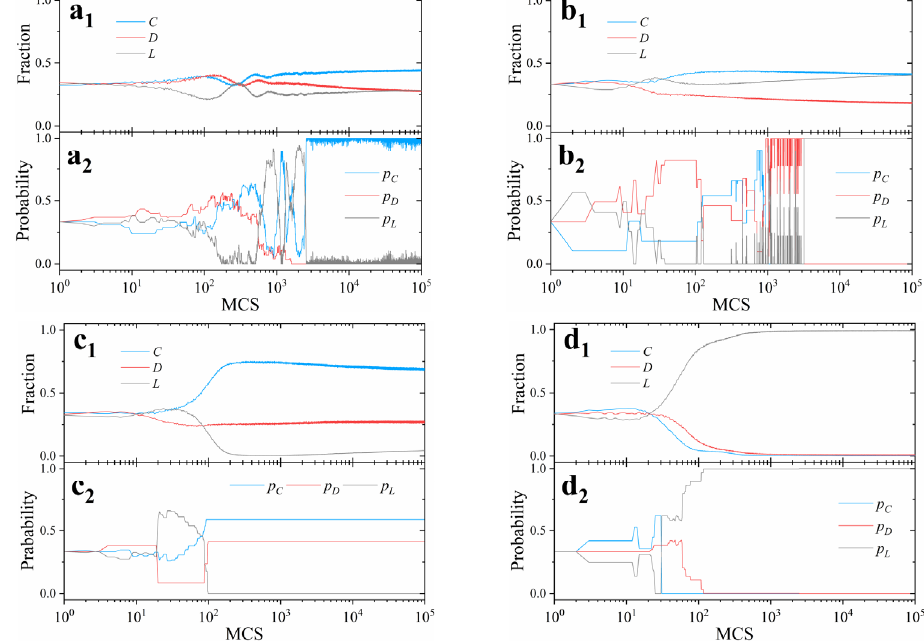
Figure 5. Evolutionary processes of the fraction for each strategy, as ( a 1 ) ω C = ω D = 0.02; ( b 1 ) ω C = ω D = 0.2; ( c 1 ) ω C = 0.02, ω D = 0.2; ( d 1 ) ω C = 0.2, ω D = 0.02 and the corresponding evolutionary processes of a typical individual’s mixed strategy ( a 2 – d 2 ). The other parameters are 𝑟 = 3.5 , 𝛼 = 1 , 𝛾 + = 𝛾 − = 0.5 , 𝜆 = 2 , and 𝑀 = 100 .